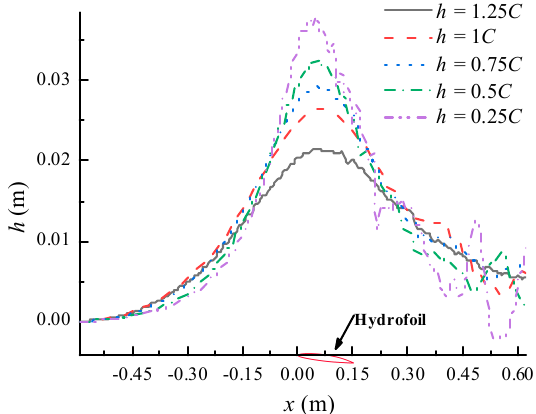
Figure 21. Free surface change caused by hydrofoil cavitation near the free surface in different depth at the same cavitation cycle stage.